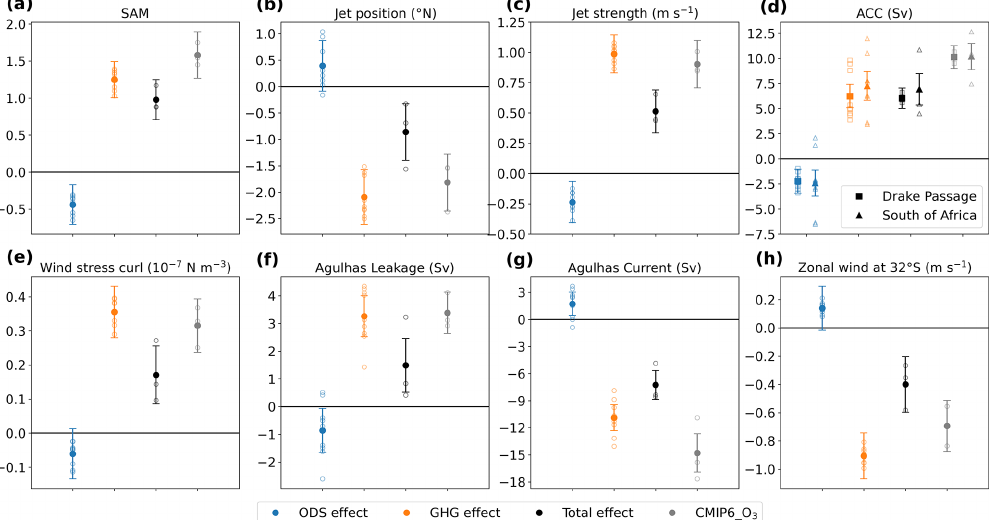
Figure 15. Changes in the annual mean SAM index calculated following the definition of Gong and Wang (1999) as the difference in the normalized zonal-mean SLP between 40 and 65 ◦ S (a) ; surface westerly jet position computed as the latitude of the maximum in the zonal-mean zonal wind between 30 and 65 ◦ S ( b ; ◦ of latitude, positive northward); surface westerly wind strength averaged between 45 and 60 ◦ S ( c ; ms − 1 ); ACC transport ( d ; Sv) in the Drake Passage, computed as the difference in the barotropic stream function between the Antarctic Peninsula and South America (circles), and south of Africa, computed as the maximum in the barotropic stream function between 20 and 30 ◦ E (triangles); wind stress curl averaged between 40 and 55 ◦ S and 30 and 120 ◦ E ( e ; 10 − 7 Nm − 3 ); Agulhas leakage transport ( f ; Sv); Agulhas Current transport ( g ; Sv); and the zonal wind at 32 ◦ S averaged between 30 and 120 ◦ E ( h ; ms − 1 ). Filled symbols depict the change in the ensemble mean, and hollow symbols depict the change in the individual members due to ozone recovery (blue) increasing GHGs (orange), combined forcing in INTERACT_O 3 (black), and combined forcing in CMIP6_O 3 (gray). The error bars denote the 95% confidence interval based on a two-tailed t